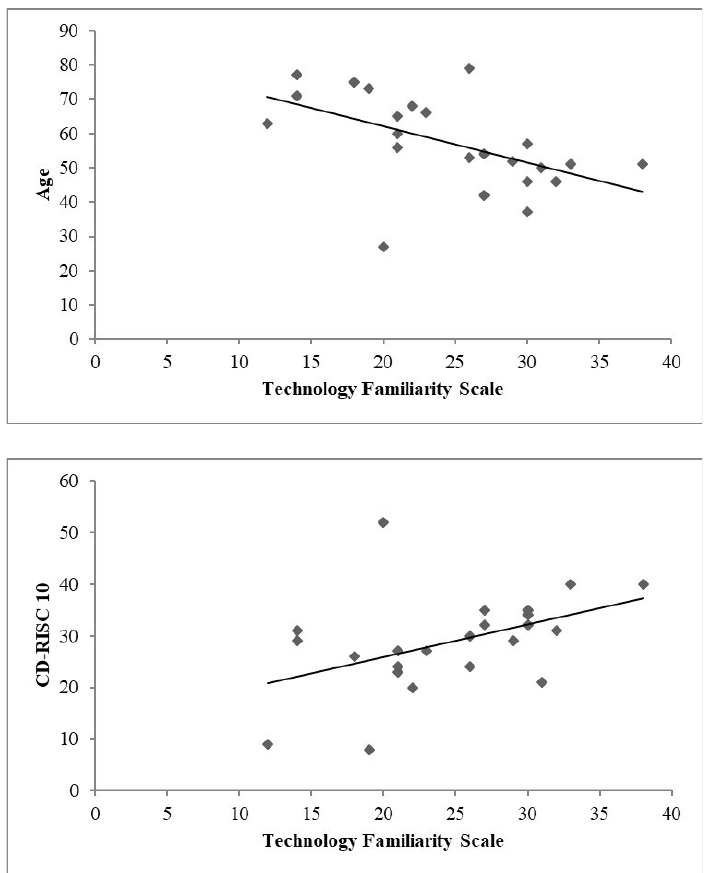
Impact of Age and Resilience on Technology